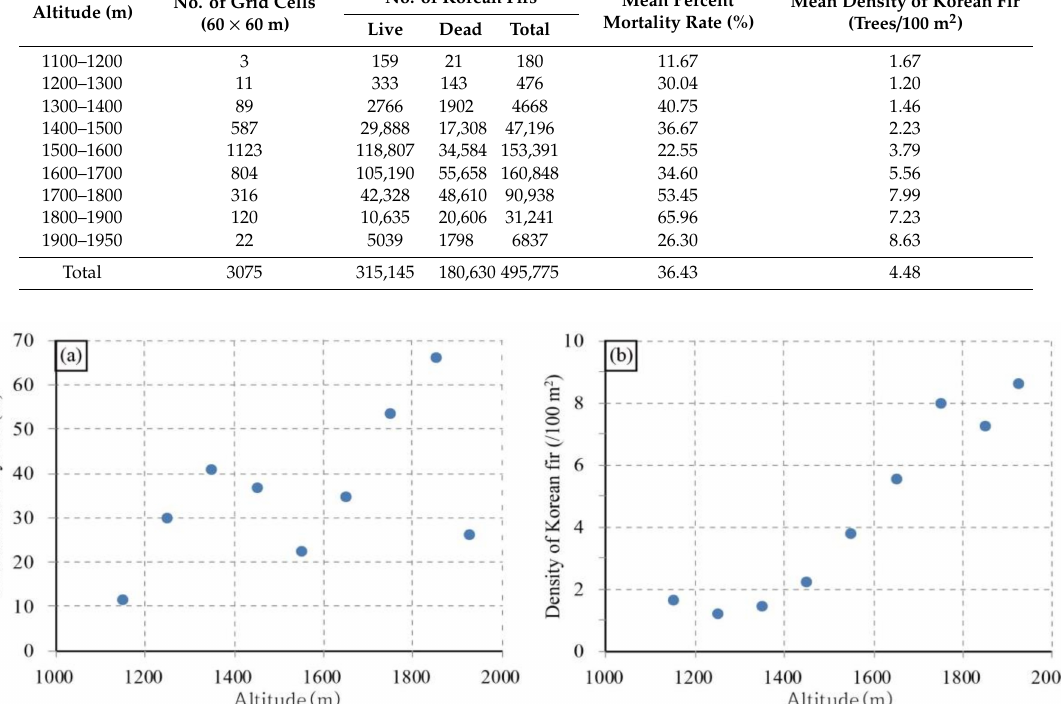
Figure 3. Altitudinal pattern of APMR ( a ) and density of Korean fir ( b